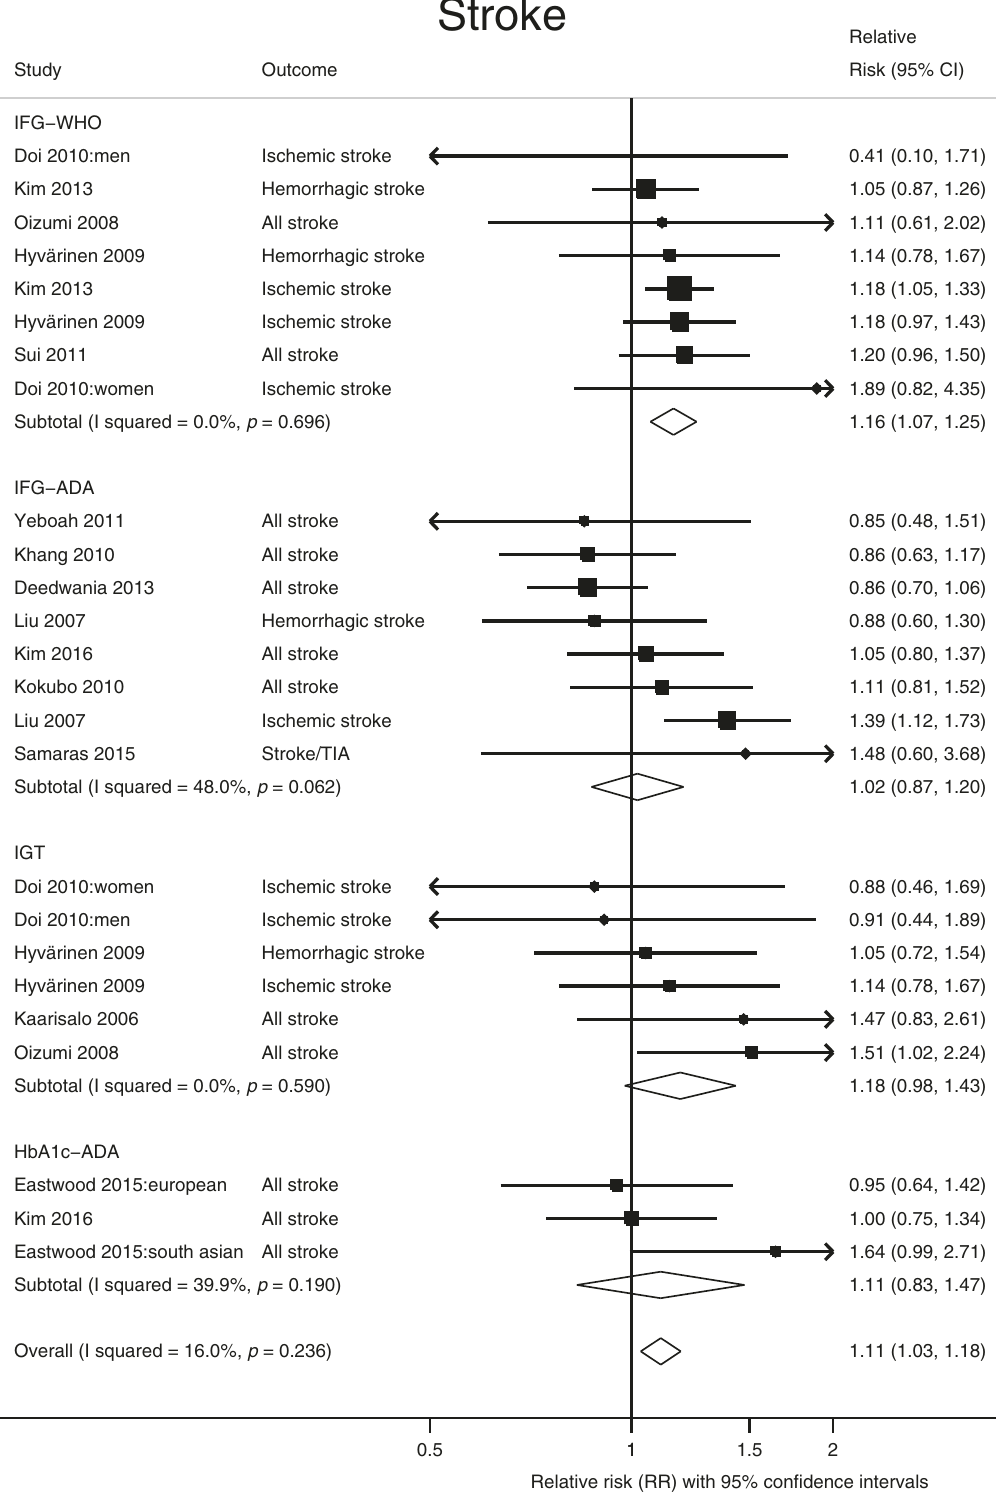
Overall (I squared = 16.0%, p = 0.236)